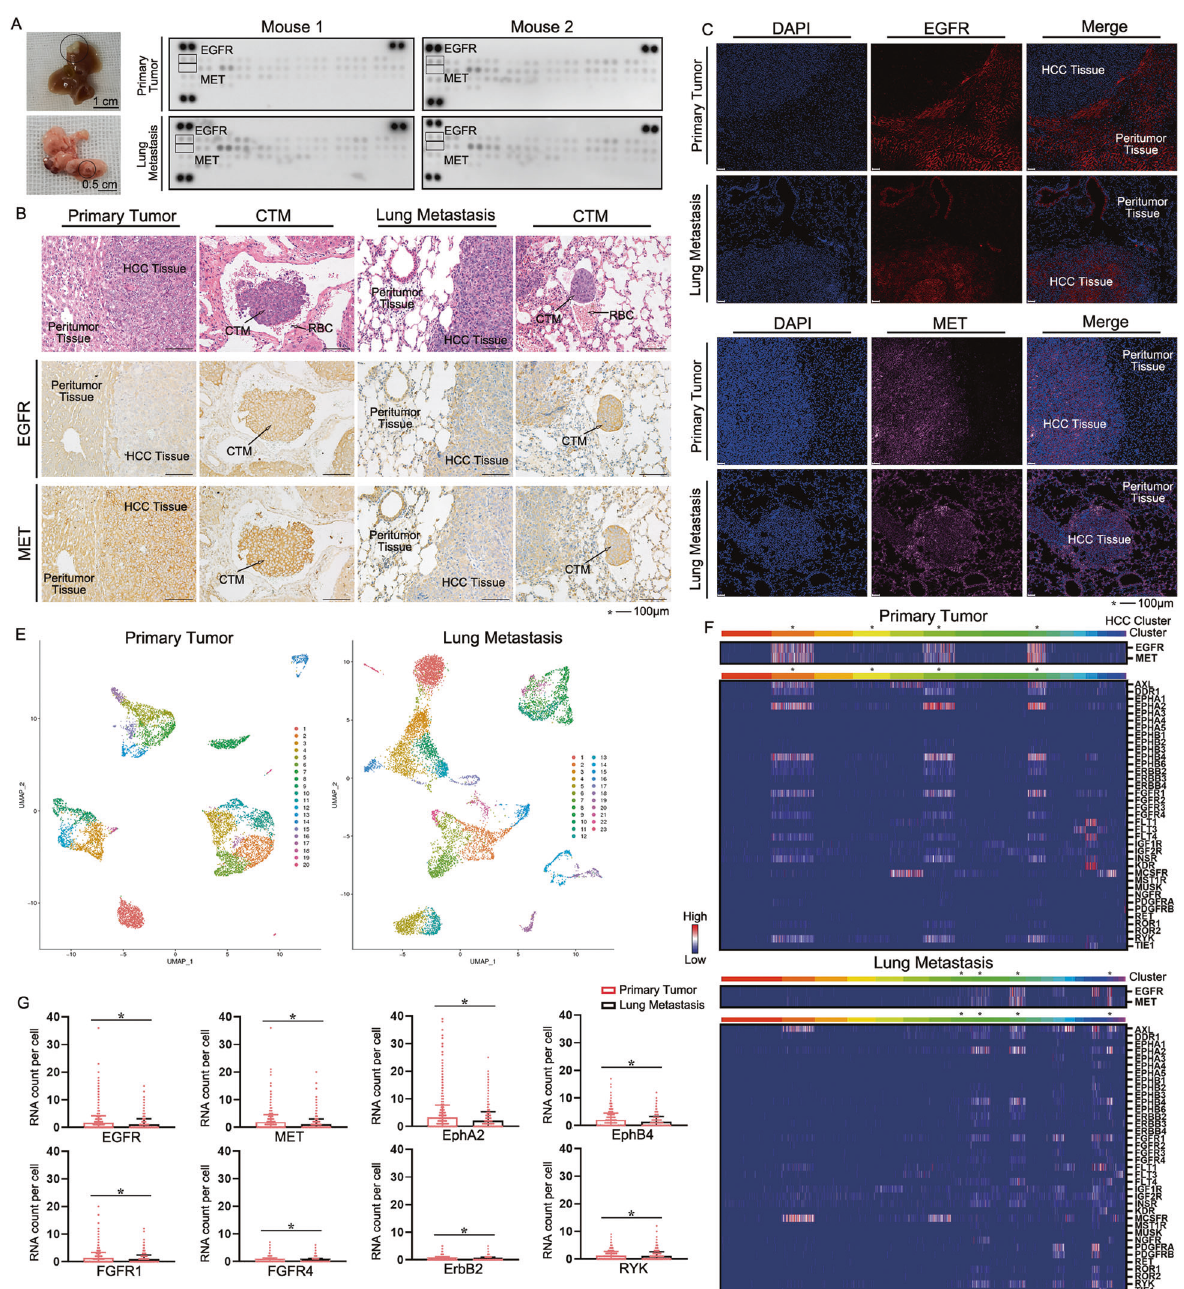
Fig. 2 Expression of EGFR/MET is higher in CTM but lower in lung metastasis. A Gross image of HCC and lung metastasis in mice 60 days after injection of Hepa1-6 cell line. B Mice Phosphorylation Array was used for detection of RTK phosphorylation of HCC tissue separated from liver and lung. C Immuno fl uorescence analyzed the differences of EGFR/MET expression in cancer tissues and peritumor tissues in liver and lung. D Immunohistochemistry analyzed the differences of EGFR/MET expression in cancer tissues and CTM. E UMAP showed different clusters in carcinoma tissues of liver and lung. F Distribution of RTKs were showed in each cell of primary tumor and lung metastasis with Single cell RNA sequence by heatmap. G Difference of RTKs with high expression in carcinoma tissue between primary tumor and lung metastasis were showed. Data are shown as the mean ± SD, * P < inhibitory effect of EGFR/MET inhibitors was greatly reduced, and suspension. Phosphorylation RTKs array reported that phosphor- secretion of IL-8 could interrupt by EGFR inhibitor was relatively ylation of EGFR/MET in suspended HCC cell lines was enhanced obvious (Fig. 3C). Also, inhibition of EGFR/MET made HCCLM3 cell and Western blot assays indicated that peak point appeared at lines more easily killed by leukocytes and more leukocytes could 24 – 48 h (Fig. 3A, B). IL-8 synthesis/secretion could be interrupted survive (Fig. 3D), which were not bene fi cial to hematogenous by EGFR/MET inhibitor, which was observed in MHCC97H cell lines metastasis of HCC cell lines. The fi ndings suggested that EGFR/ with high phosphorylation of EGFR/MET. However, in PLC/PRF/5 MET played an important role in the metastasis of HCC cells. HCC cell lines with lower phosphorylation of EGFR/MET, the